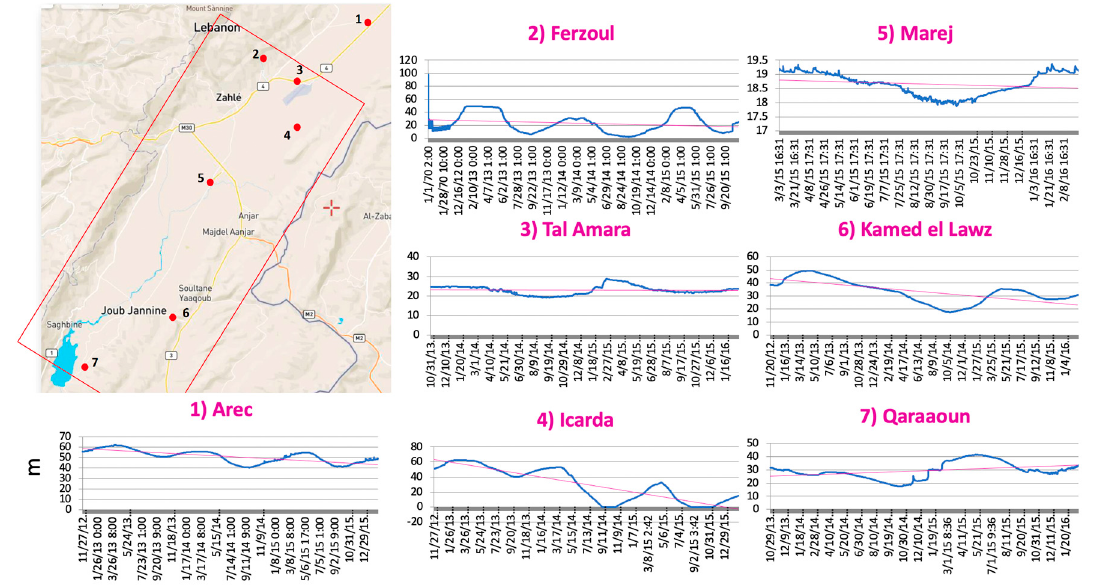
Figure 9. Monitoring wells for 7 chosen locations, indicated on the map with red dots. These individual cases show the seasonal signals of groundwater depletion and recovery, but overall, there is a long-term trend of depletion in most of these wells and this is due to unsustainable groundwater pumping. Units for the timelines showing the groundwater well dynamics are in (m).